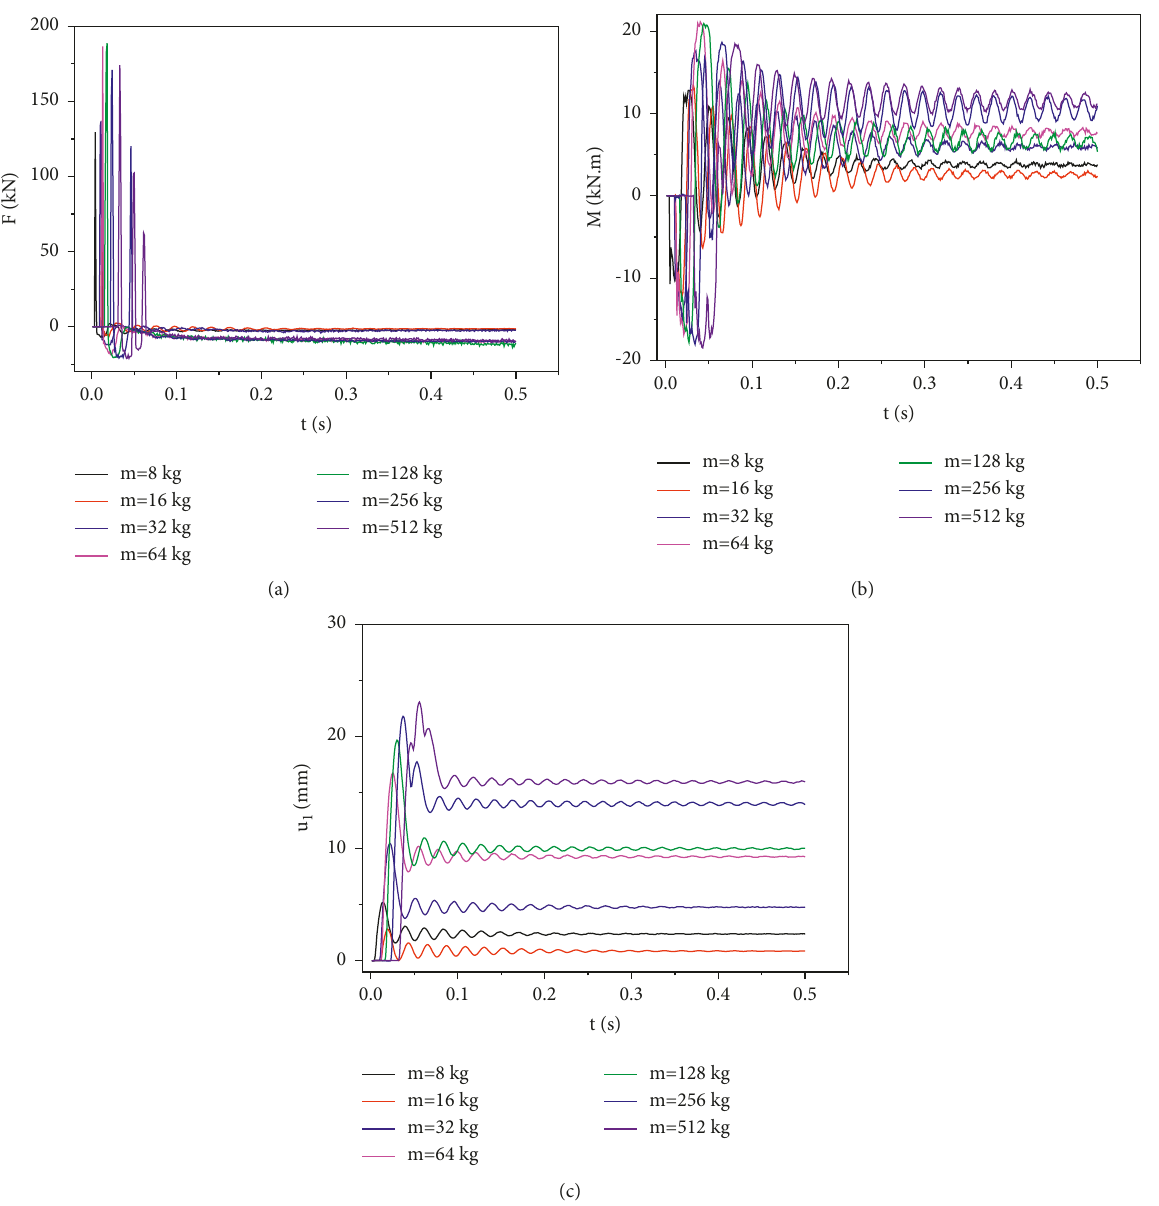
Figure 12: Dynamic response when Ek � 0.64kJ. (a) F- t ; (b) M- t ; (c) u1- t